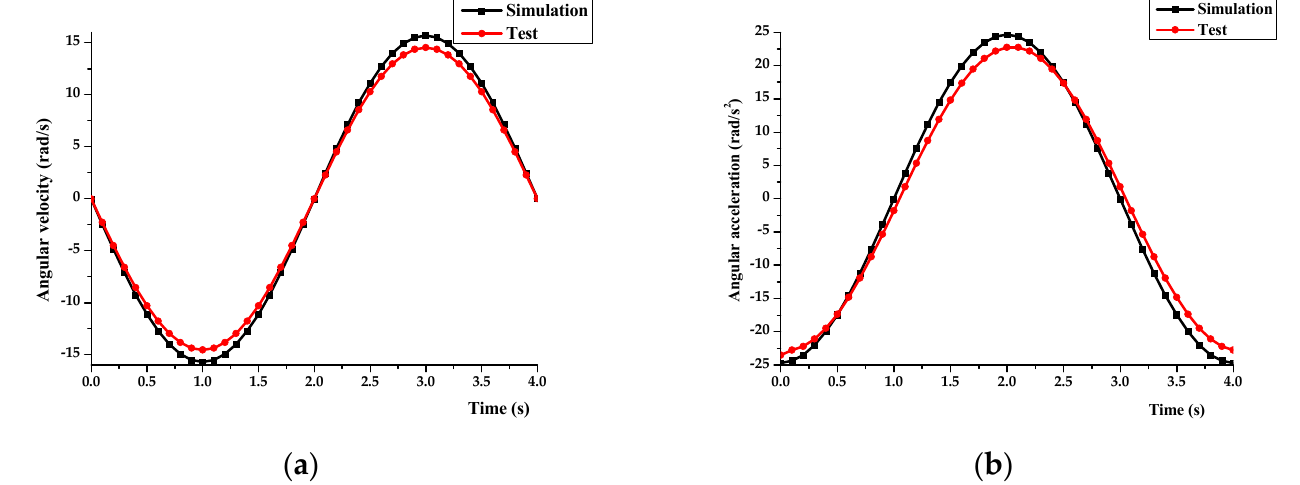
Figure 21. ( a ) Angular velocity ( b ) Angular acceleration comparison chart of the roll motion. In pitch motion, the maximum angular velocity of the platform simulation was 15.71 rad/s, and the maximum angular velocity of the actual measurement was 14.36 rad/s. The velocity of the simulation and the actual measurement is shown in Figure 22a. The maximum angular acceleration of the simulation was 24.67 rad/s 2 , and the maximum angular acceleration of the actual measurement was 22.46 rad/s 2 , as shown in Figure